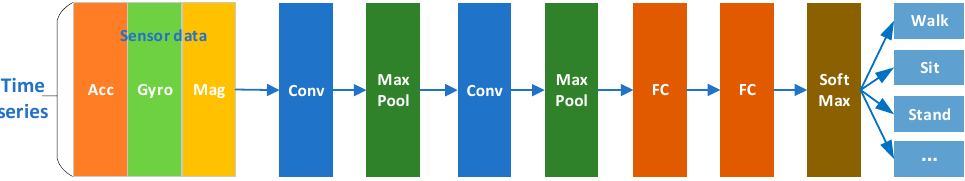
Figure 2. CNN framework we used. We used two convolutional layers, two pooling layers, two fully connected layers. The last fully connected layer and Softmax form a classifier.